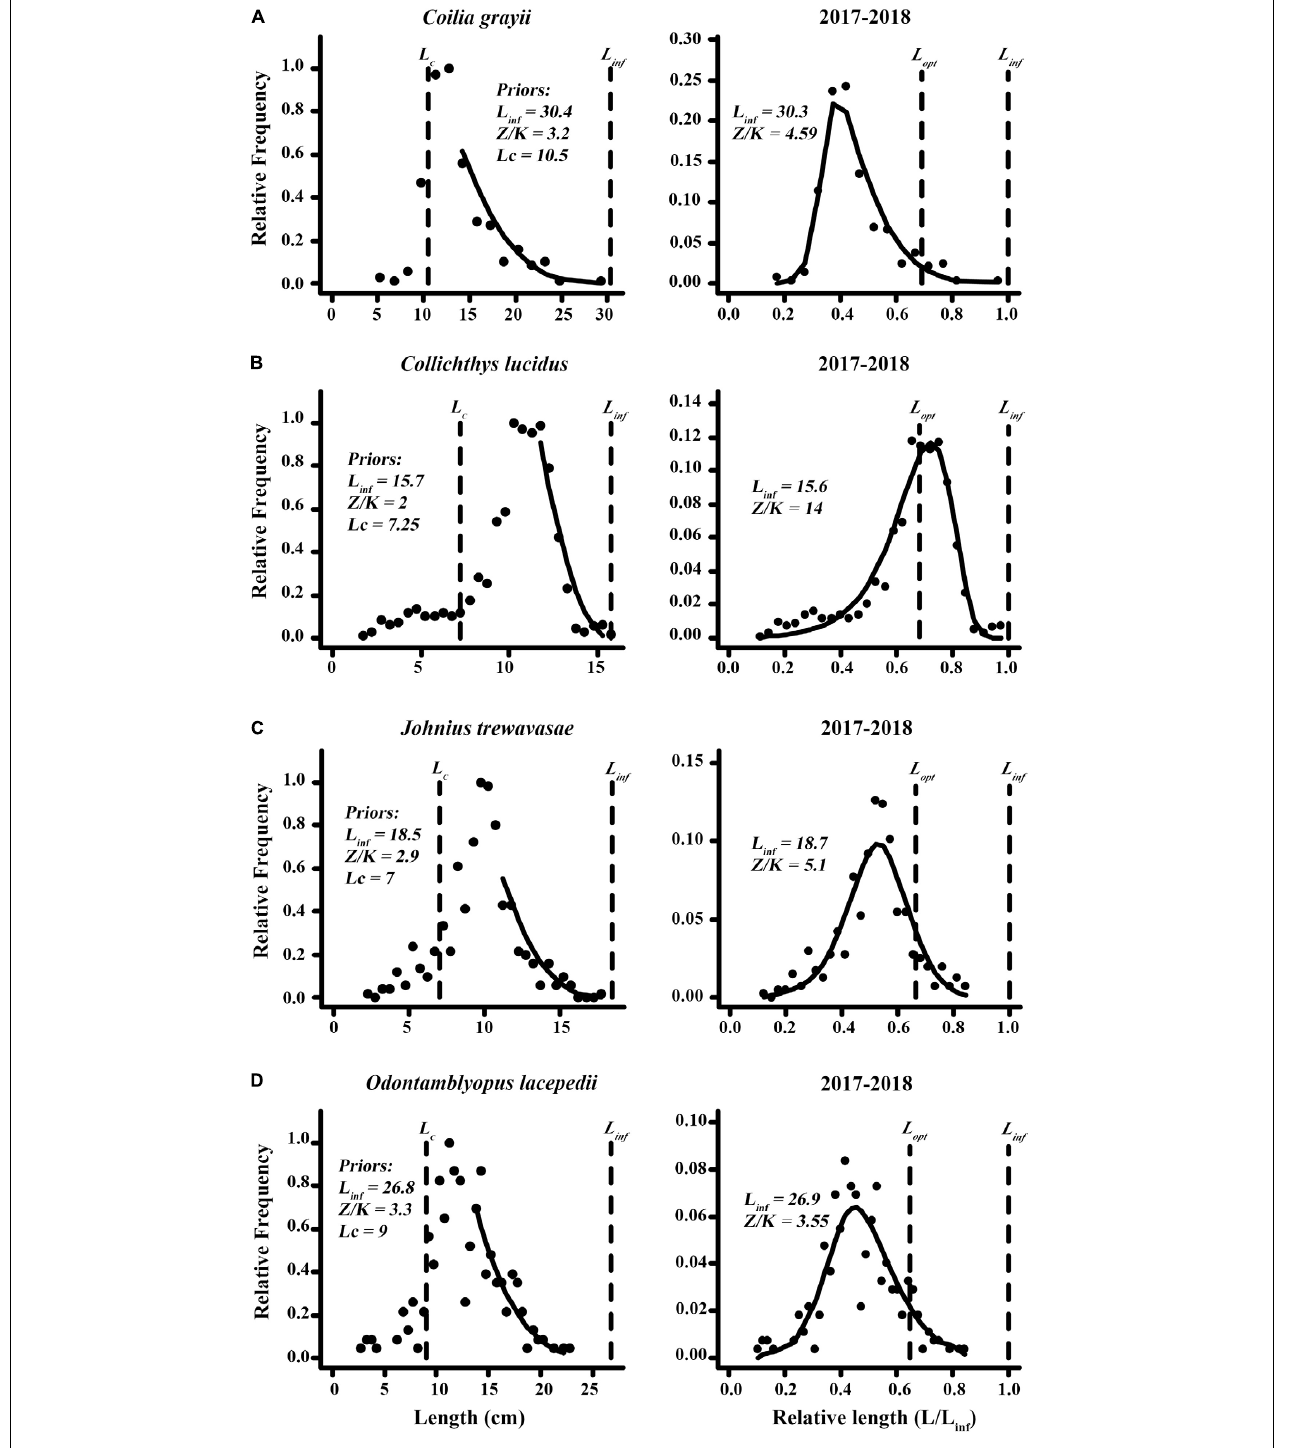
FIGURE 2 | Results of assessment of four fish species with an overexploited stock status in the Min River Estuary and its adjacent waters, Fujian Province, southern China, with length data in 2017 and 2018. (A) Coilia grayii , (B) Collichthys lucidus , (C) Johnius trewavasae , and (D) Odontamblyopus lacepedii . The left panels estimate the length at 50% first capture ( L c ), the asymptotic length ( L inf ), and the total mortality relative to somatic growth ( Z/K ) based on the catches of 2017 and 2018 as prior. The curves are fitted to fully selected length classes and provide the estimates of L inf and Z/K . The right panels show the length-frequency data from 2017 and 2018. The curves show the fitness of the LBB master equation and provide the estimates of L inf and Z/K . The L opt is calculated from L inf and M/K , where the biomass of the unexploited stock is maximum.